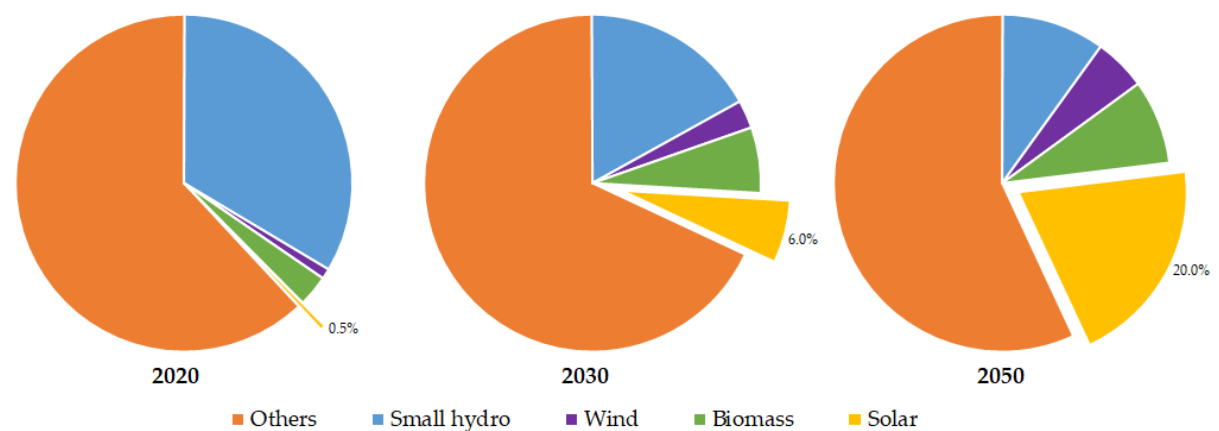
Figure 7. Targets for electricity production by renewables under REDS in Vietnam. Reprinted with permission from Ref. [56]. Copyright 2015 Vietnam Government. Table 1. The FIT for grid-connected solar PV in 2017–2020. Reproduced from [36–38], Vietnam